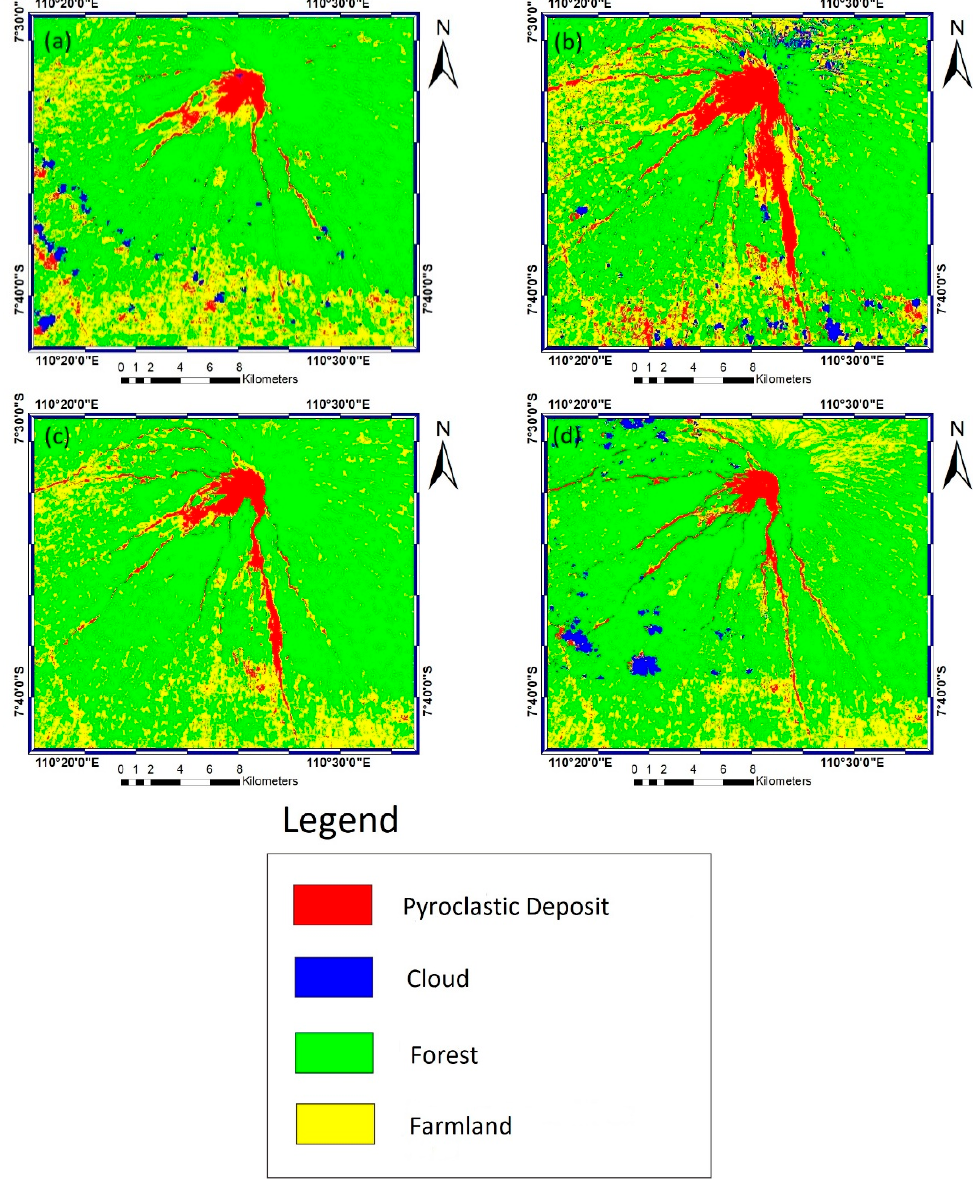
Figure 6. Supervised classification maps using ANN processing in the ENVI program of Mount Merapi Landsat imagery data taken on: ( a ) 16 June 2007; ( b ) 10 May 2011; ( c ) 2 November 2014; and ( d ) 23 May 2017.